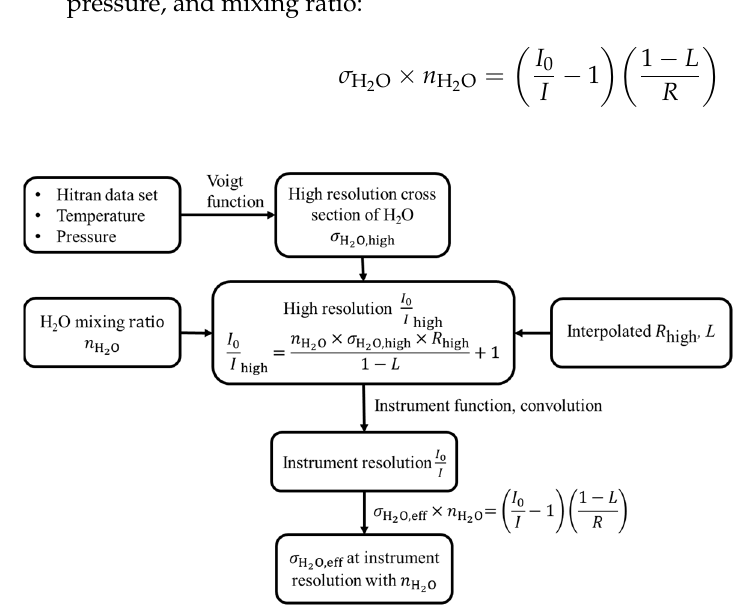
Figure 4. The flow diagram of the calculation of effective cross section of water vapor at instrumental spectrum resolution.